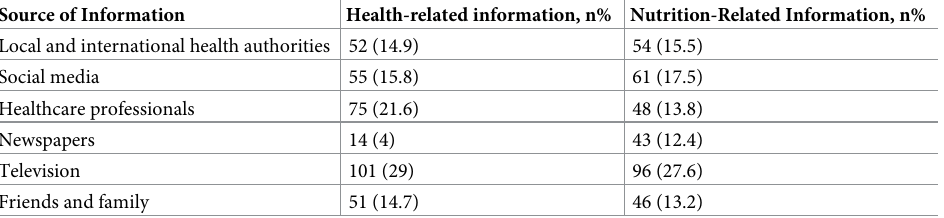
Table 2. Sources of information of the study